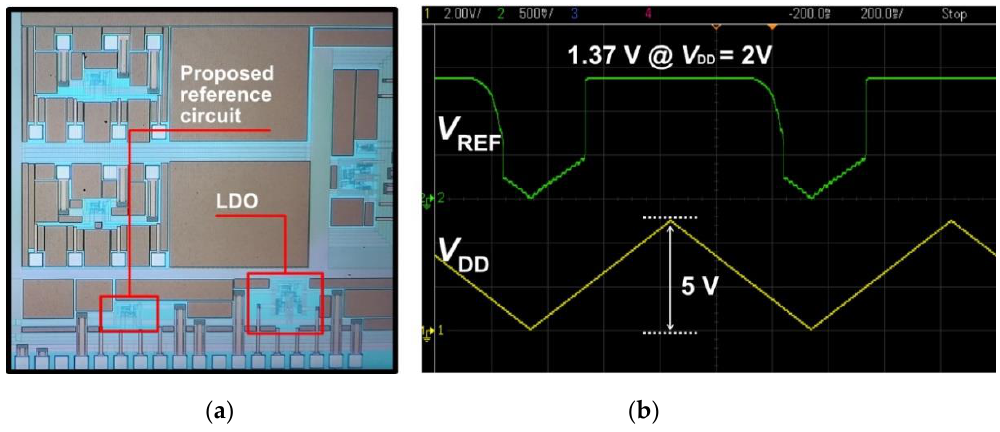
Figure 3. ( a ) Micrograph of the proposed reference circuit, ( b ) measured transient response.